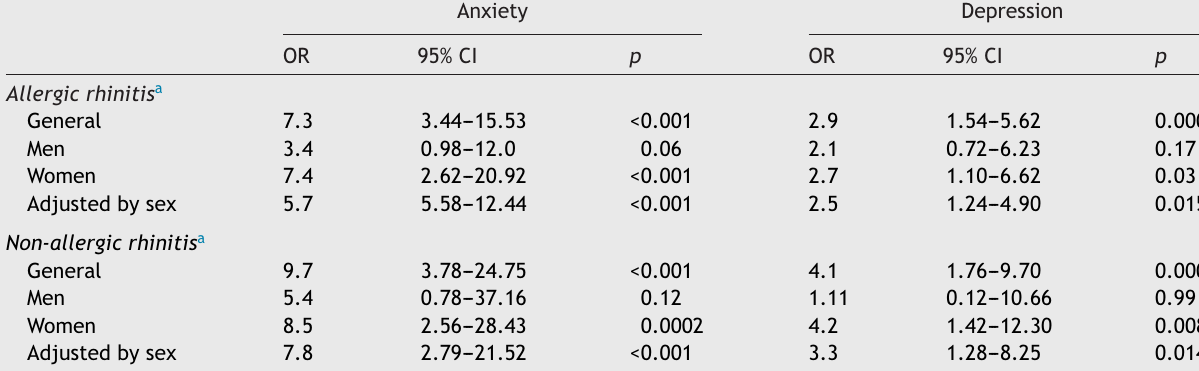
Risk of anxiety and depression in subjects with rhinitis adjusted by sex.